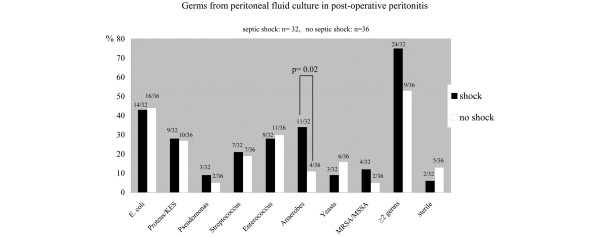
Proportion of microorganisma isolated from peritoneal fluid culture in postoperative peritonitis with (black bars) or without (white bars) septic shock. On the top of each bar: number of patients in whom the microorganism was identified with respect to total number of patients in the subgroup (shock: n = 32; no shock: n = 36). KES = Klebsiella, Enterobacter, Serratia. MRSA/MSSA = methicillin-resistant Staphylococcus aureus/Methicillin-sensitive Staphylococcus aureus.